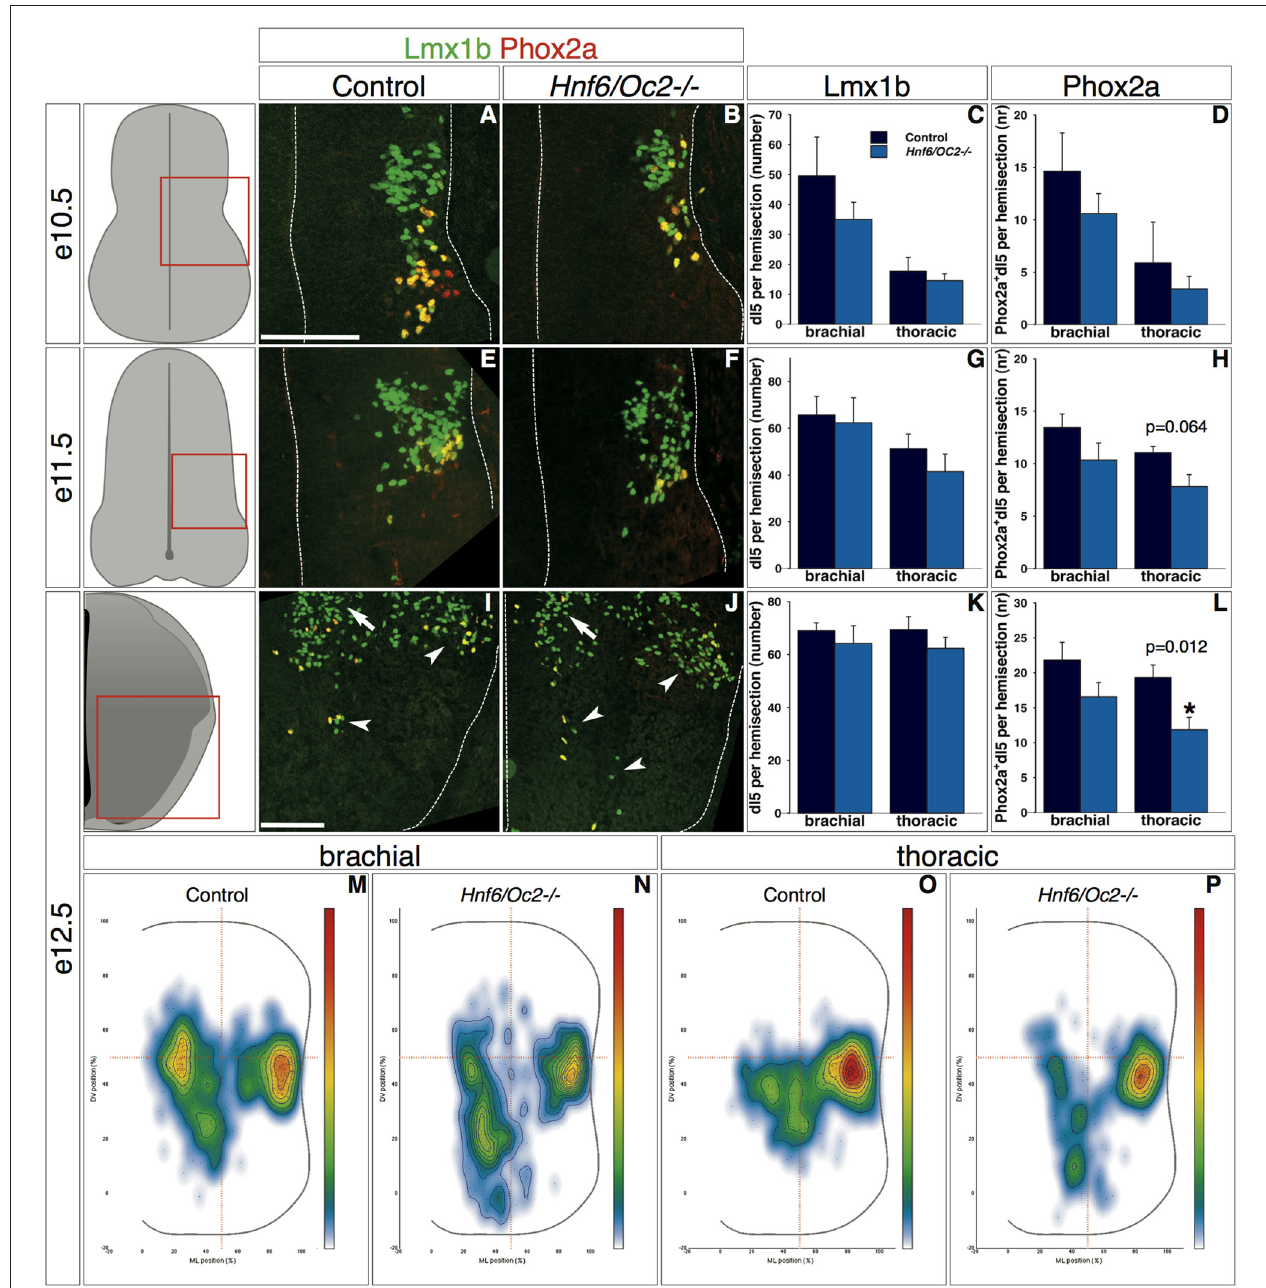
FIGURE 5 | OC factors control the number and the distribution of Phox2a + dI5 cells. (A–L) Identification of dI5 interneurons and Phox2a+ dI5 subset in control or Hnf6/Oc2-/- embryos. At embryonic stage e10.5 (A,B) , Lmx1b is present in dI5 interneurons and Phox2a is detected in a small subset of dI5 cells. (C,D) Quantitative analysis shows that number of Lmx1b+ and of Lmx1b+Phox2a+ dI5 neurons at brachial or thoracic levels are comparable in control or Hnf6/Oc2-/- mutant embryos ( n = 4). At e11.5 (E,F) and e12.5 (I,J) , most Lmx1b+ dI5 are located medio-laterally or migrating ventrally whereas Lmx1b+ late-born dILB extend dorsally along the ventricular zone. Phox2a labeling is still restricted to a medio-lateral (ML) subset of dI5 neurons at e11.5 but laterally and ventrally disperses (arrowheads) at e12.5. (G,H,K,L) Quantitative analysis shows similar numbers of Lmx1b+ and Lmx1b+Phox2a+ dI5 cells in control and in mutant embryos at embryonic stage e11.5 ( n = 3) and e12.5 ( n = 4 for control and n = 7 for mutant embryos) except for a significant decrease of Phox2a+ dI5 subset at thoracic level of e12.5 mutant embryo ( p = 0.011). (M–P) Density plots of Phox2a+ dI5 interneuron distribution at brachial or thoracic levels of control or Hnf6/Oc2-/- mutant spinal cord at e12.5. Phox2a+ dI5 cells in the medial cluster are less densely-packed than in control spinal cord but instead spread along the dorso-ventral (DV) axis of the spinal cord. Analysis performed on at least three sections from five control and six mutant embryos ( n > 250 cells analyzed per condition; p ≤ 0.001). The pictures show left hemisections as indicated to the left. Dashed lines delineate the spinal cord and the lumen of the ventricle. Arrowheads point to lateral and ventral groups of dI5 neurons. Arrows show the medial cluster of dI5 cells. Mean values ± SEM. Scale bars = 100 µ m.